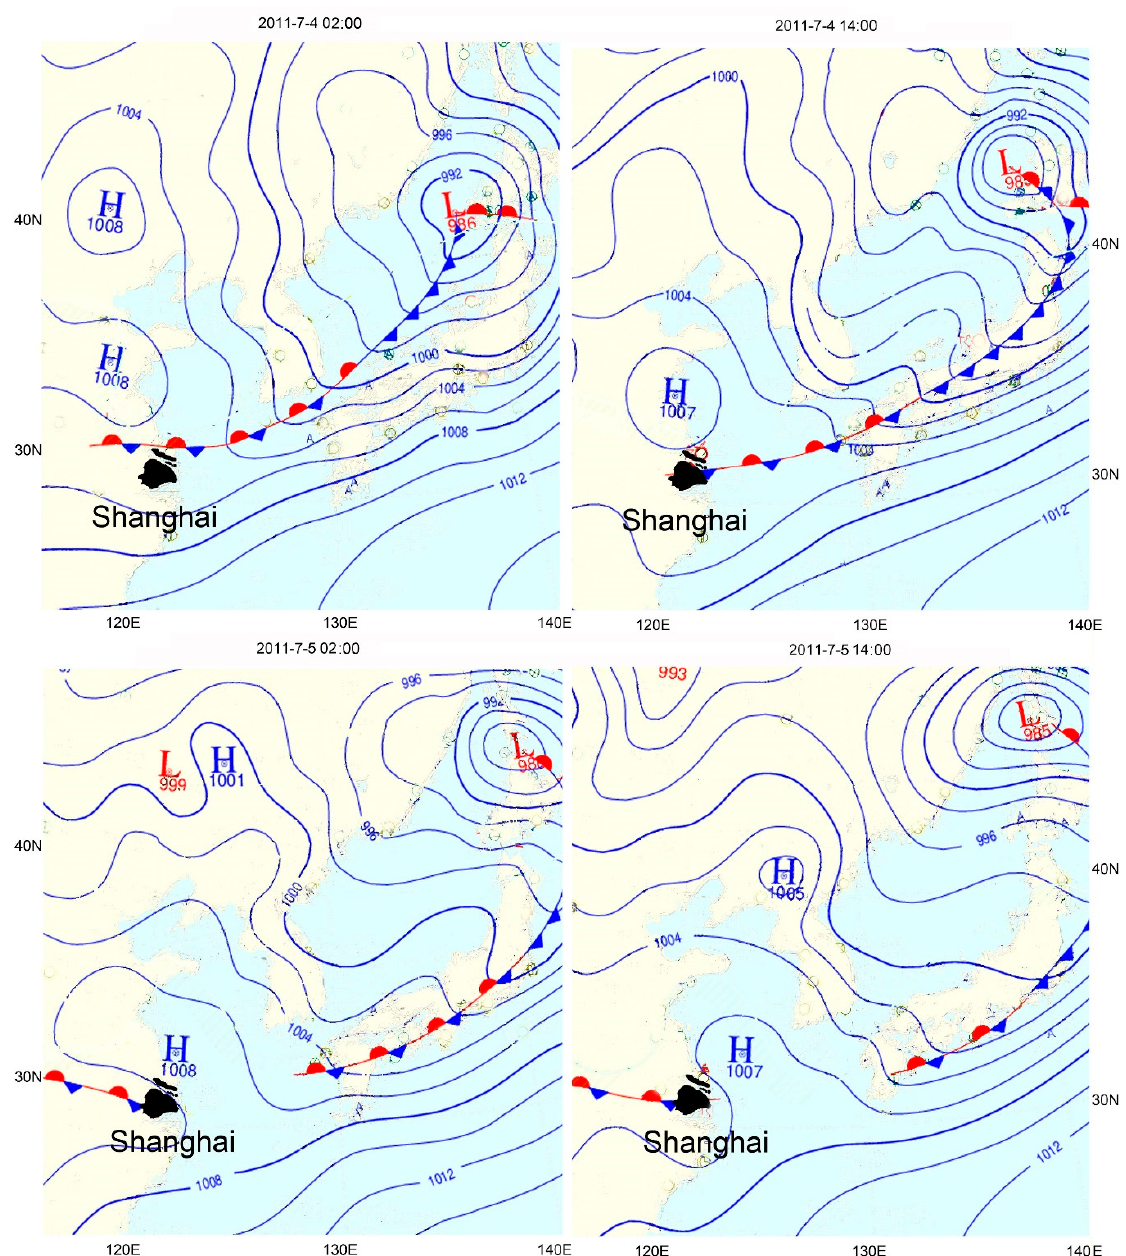
Figure 4. Weather maps of East Asia at 2:00 a.m. and 2:00 p.m. UTC + 8 on 4 July and 5 July 2011. The maps are courtesy of the Korea Meteorological Administration.